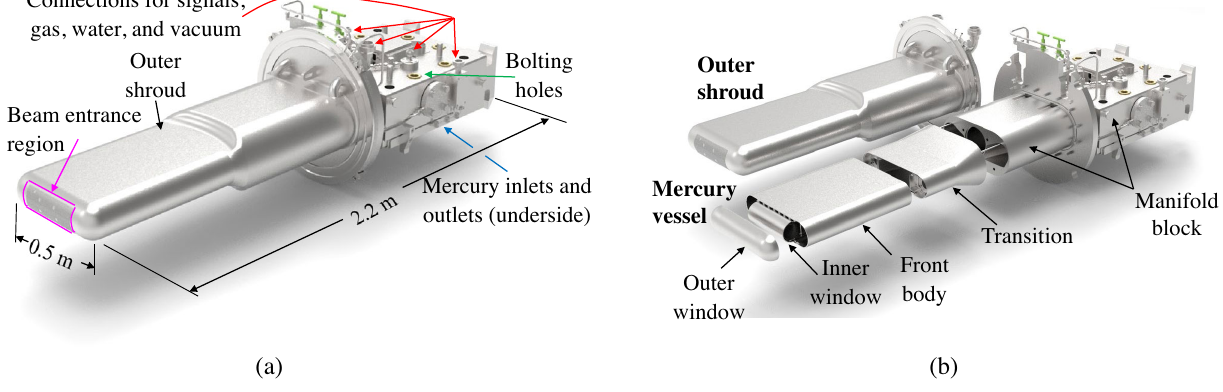
FIG. 1. Complete SNS target module (a) and exploded view of the mercury vessel next to the shroud